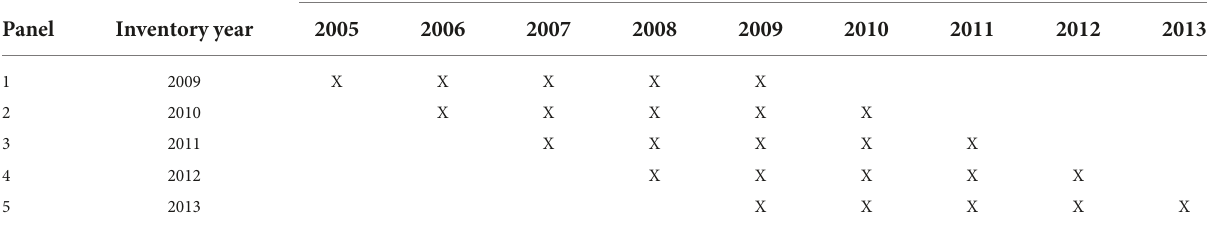
TABLE 3 Disturbance year observations in a 5-panel inventory